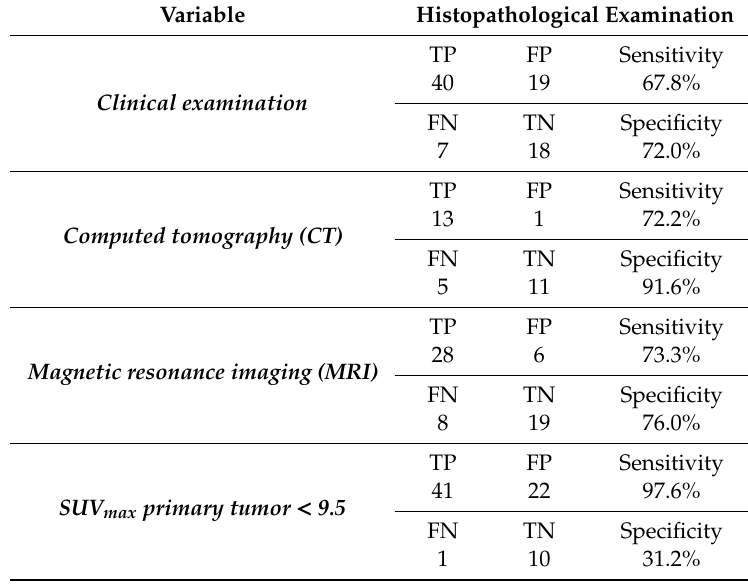
Table 2. Comparative table of prediction of bone invasion compared to histopathological standard. Variable Histopathological Examination